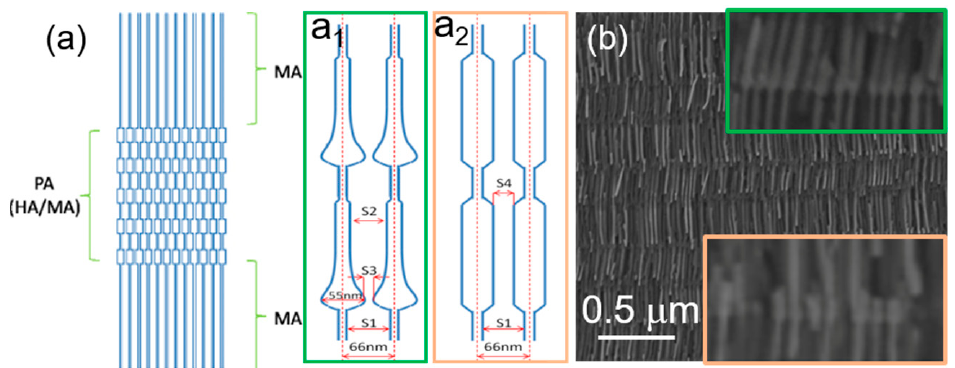
Figure 2. ( a ) Schematic illustration of nanowire geometrical features using modulated diameter within exponential ( a 1 ) and squared ( a 2 ) pulses template (Adapted with permission from ref. [23]. Copyright 2014 IOP Publishing Ltd.), ( b ) cross-section SEM image of FeCo nanowires with modulated pore diameter formed by pulse anodization in H 2 SO 4 electrolyte. The insets show the slight change in the geometry determined by the shape of the voltage pulse.